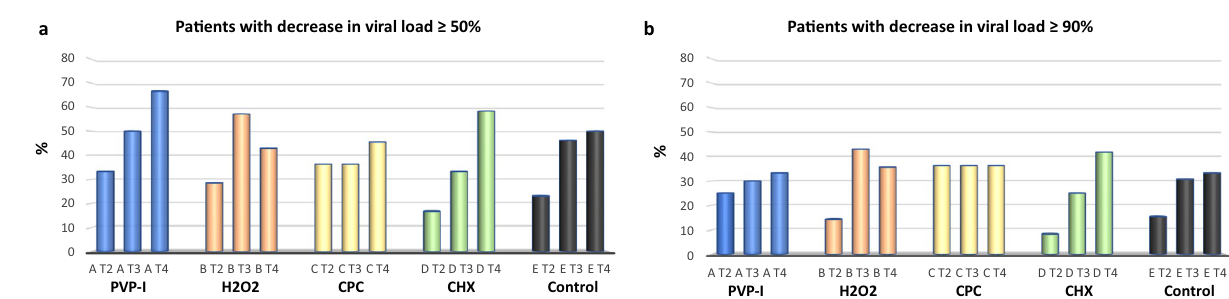
Figure 5. Patients with improvement in viral load values. Bar plots show the percentage of individuals lowering salivary viral load by 50% or higher ( a ), or 90% or higher ( b ) relative to baseline values prior to the oral rinsing treatment, at different times after the mouthwash (t2: 30 min, t3: 60 min and t4: 120 min) in each study group: PVP-I (povidone-iodine), H 2 O 2 , CPC (cetylpyridinium chloride), CHX (chlorhexidine) and control group,